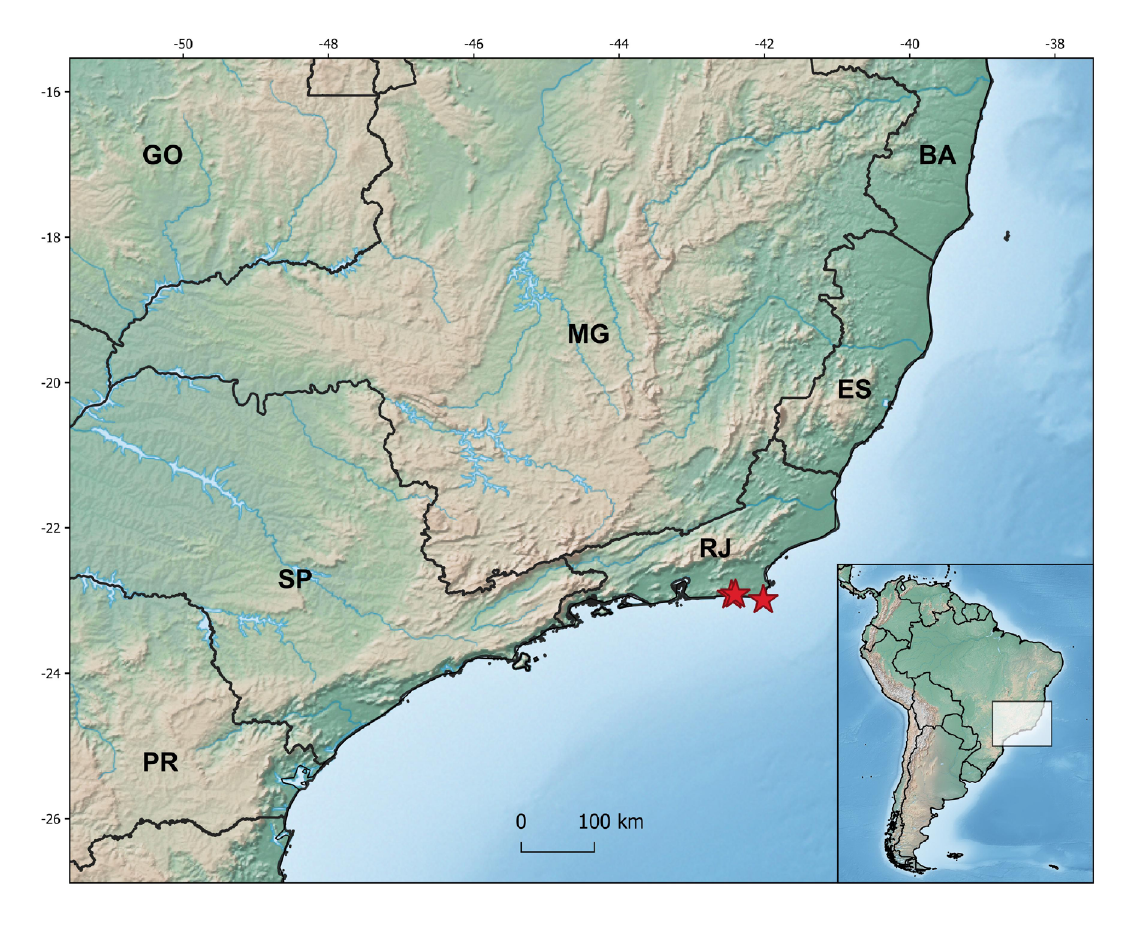
Fig. 3. Distribution map of C. restingae Sodré & Riina sp. nov. State abbreviations: BA = Bahia; ES = Espírito Santo; GO = Goiás; MG = Minas Gerais; PR = Paraná; RJ = Rio de Janeiro; SP = São